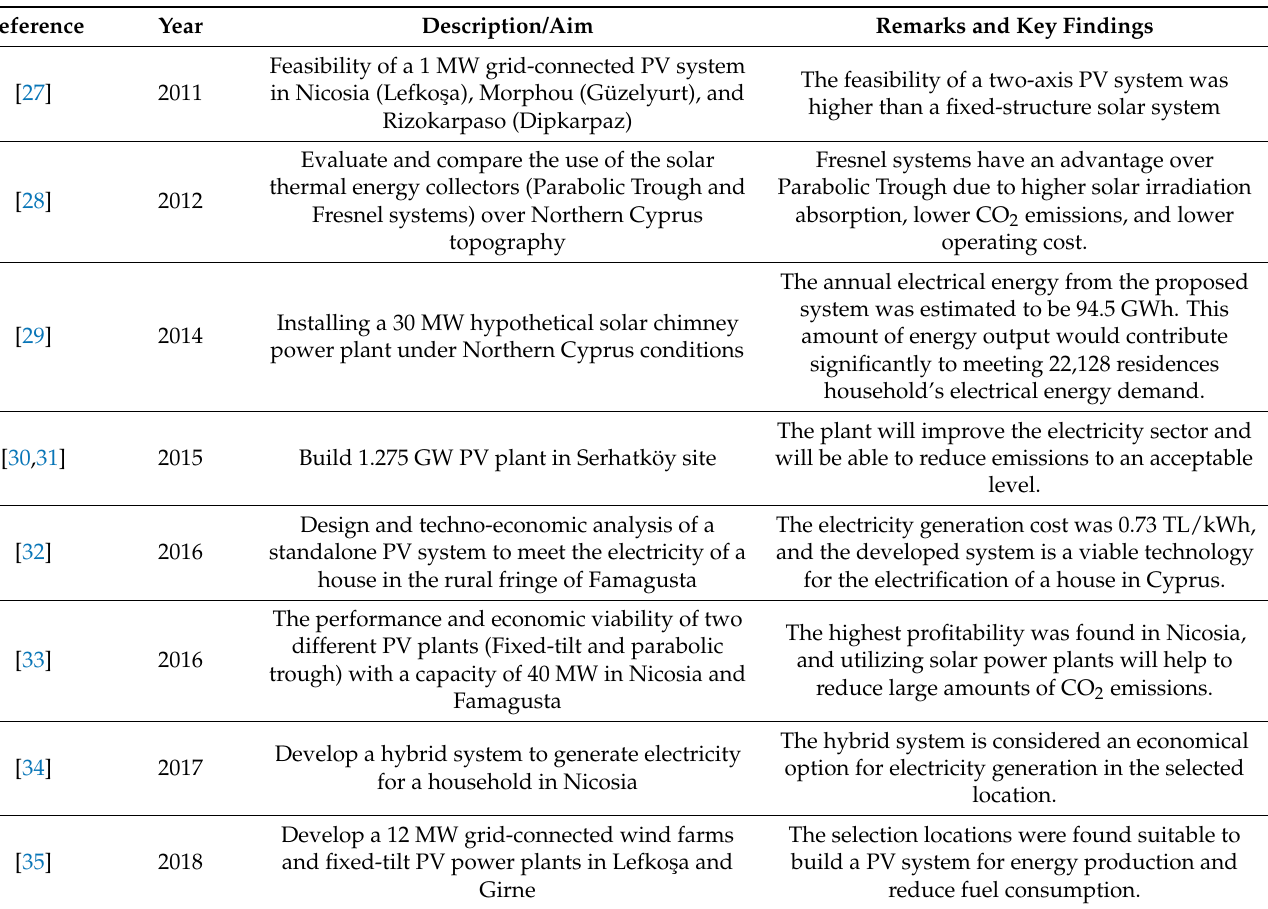
Table 1. Summary of previous studies focusing on solar energy potential in Northern